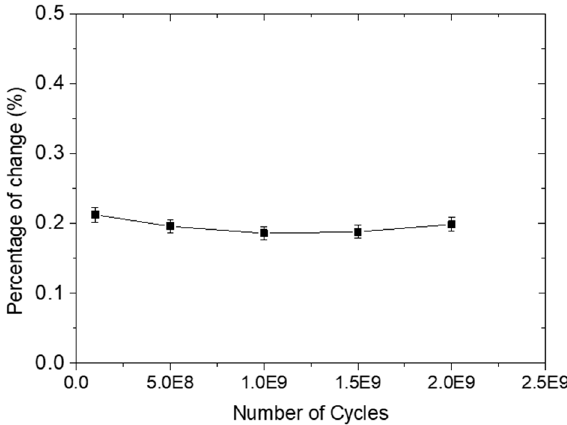
Figure 8. Percentage change in signal maximum amplitude versus number of electrical loading cycles.